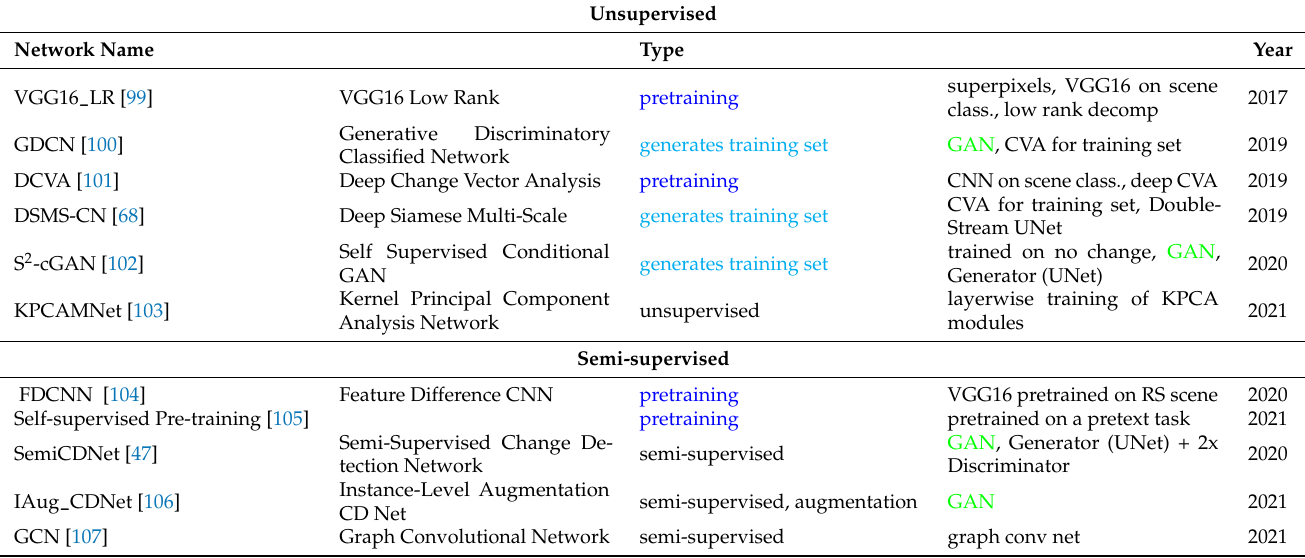
Table 3. Overview of selected unsupervised and semi-supervised change-detection models published between 2017 and 2021.